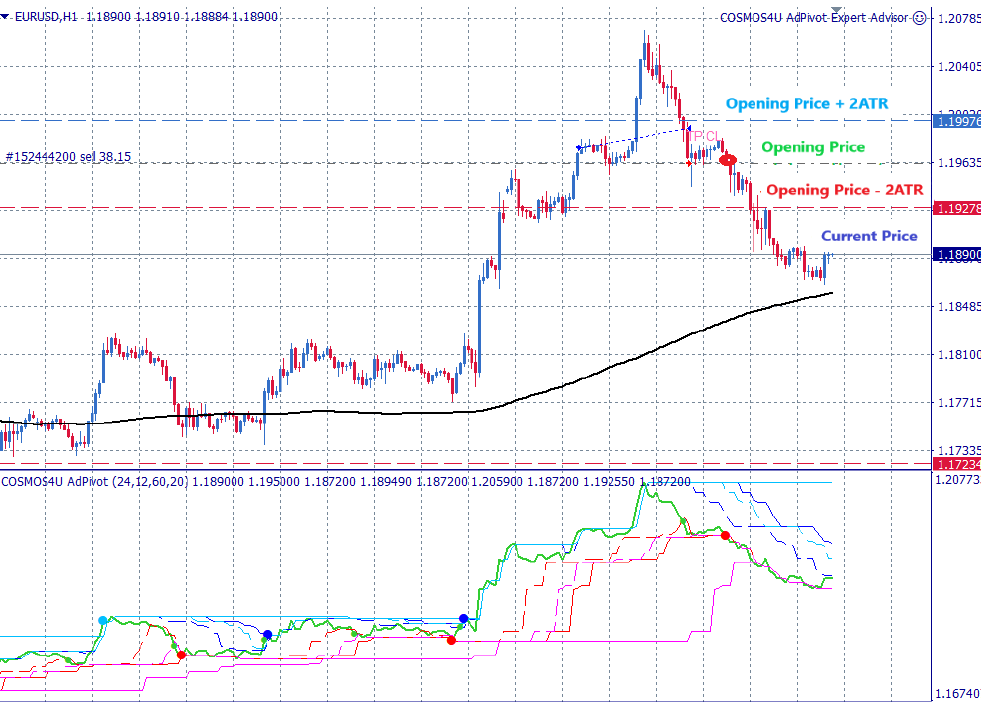
Figure 3. Short EURUSD and PIVOT indicator. Stop loss at ±